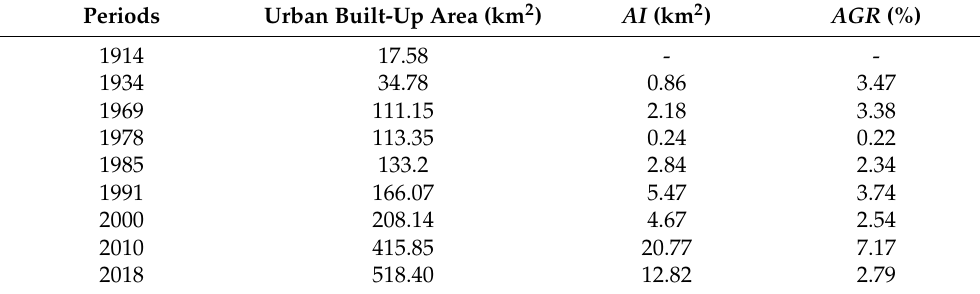
Table 3. Annual increase ( AI , km 2 ) and Annual growth rate ( AGR , %) of urban land of Hangzhou across 9 periods, from 1914 to 2018. Periods Urban Built-Up Area (km 2 ) AI (km 2